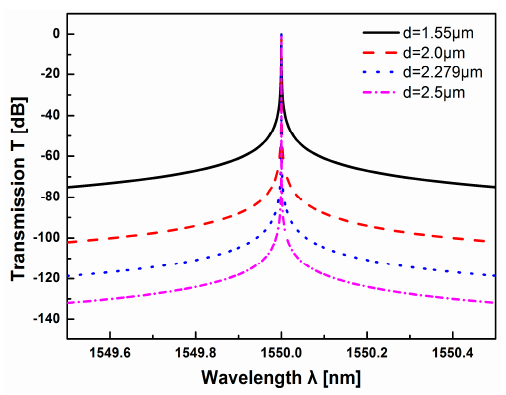
Figure 5. Transmission curves of S-polarization with respect to tunneling gap d .